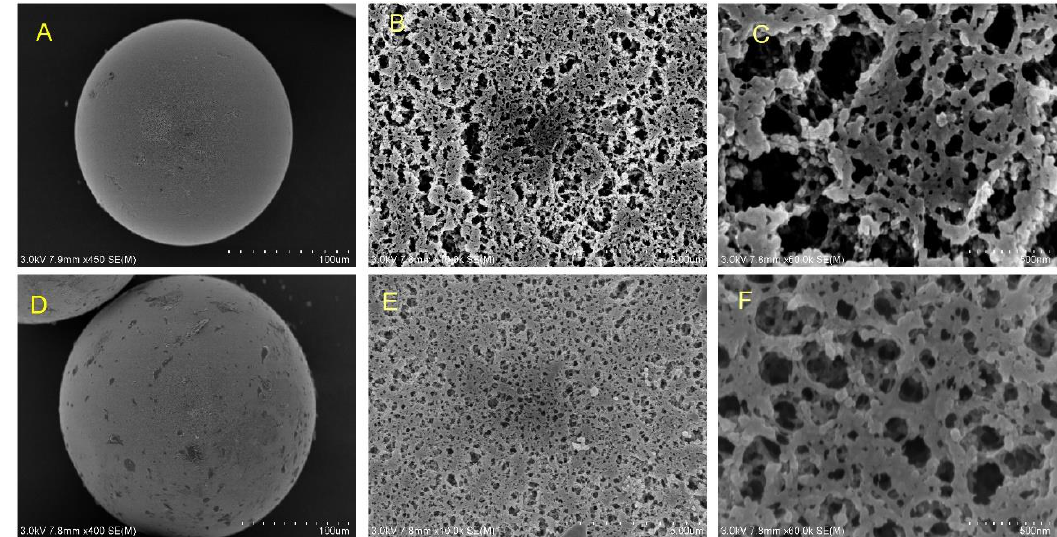
Figure 2. SEM images of resin heterofunctional resin ( A – C ) and resin immobilized with M315F/ At SuSy ( D – F ).